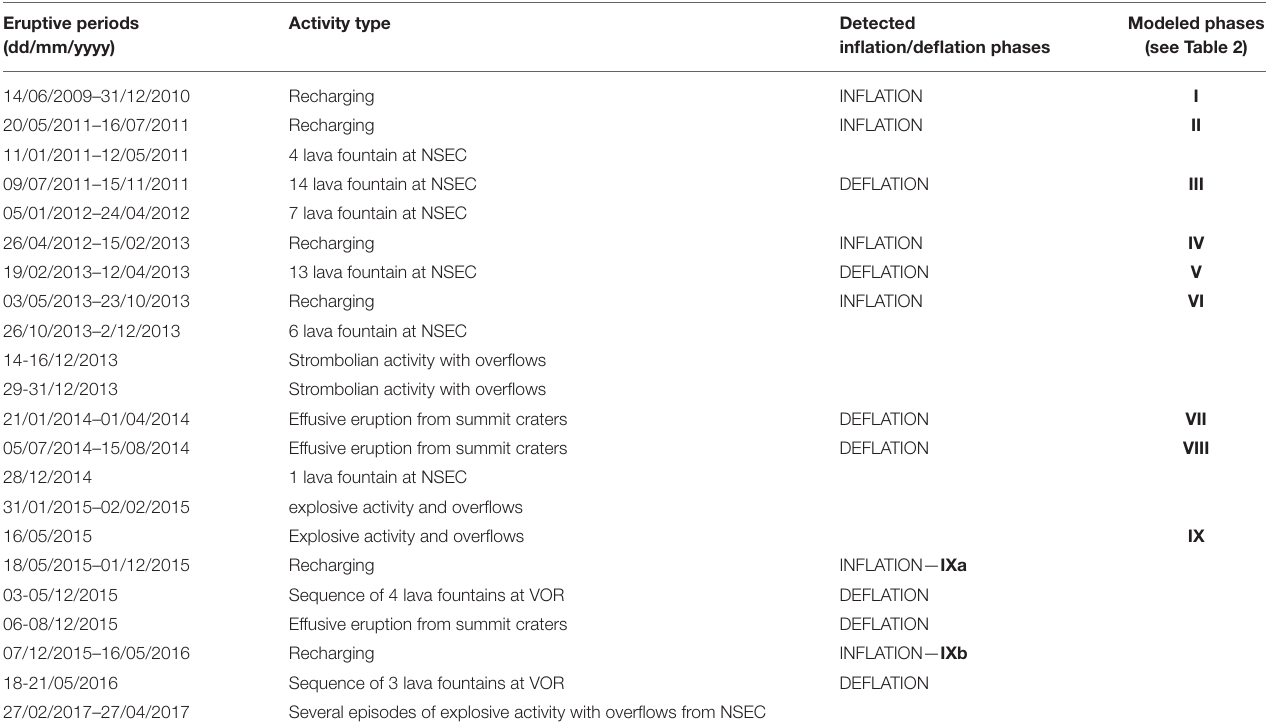
TABLE 1 | Eruptive periods from June 2009 to April 2017 with the type of eruptive activity and the detected inflation or deflation phases modeled in this study. Eruptive periods